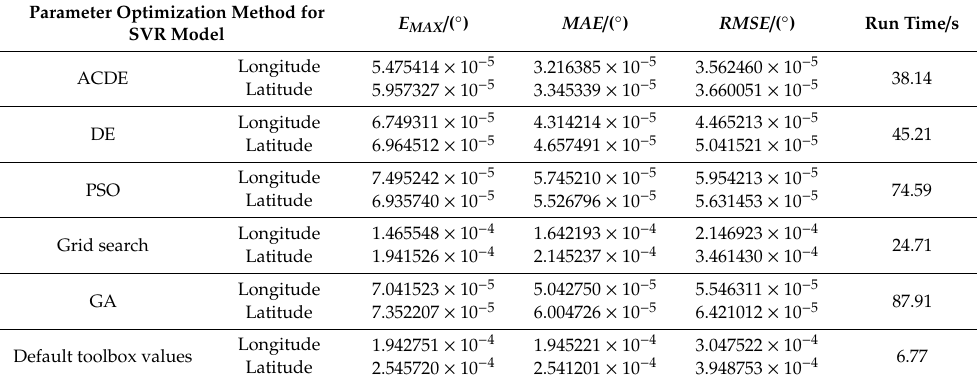
Table 5. Influence of di ff erent parameter optimization methods on prediction accuracy of SVR